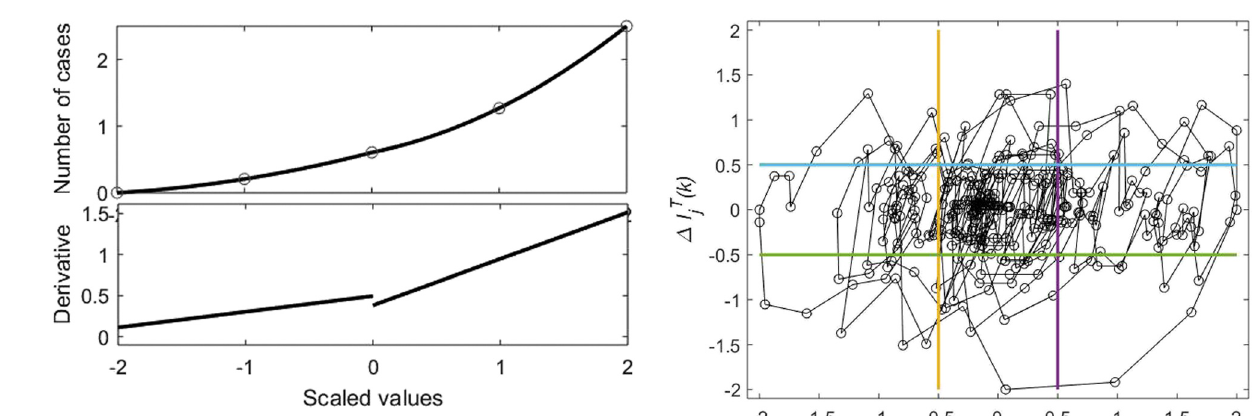
Figure 12: Nonlinear scaling for the daily new con fi rmed deaths in Finland: scaling function ( upper curve ) and derivative ( lower curve ) . ( Figure 13 ) . Also, di ff erent trend episodes are detected e ffi ciently in the full range ( Figure 14 ) . The index ( ) I k jD